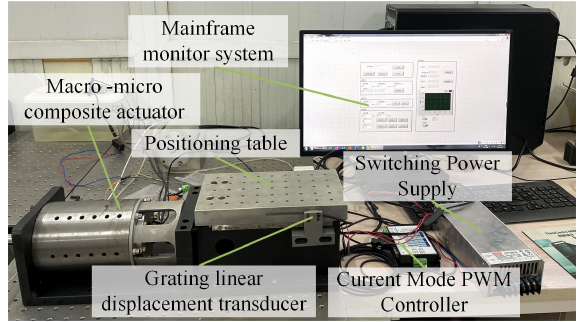
Figure 13. The experimental test platform of the macro–micro composite actuator.